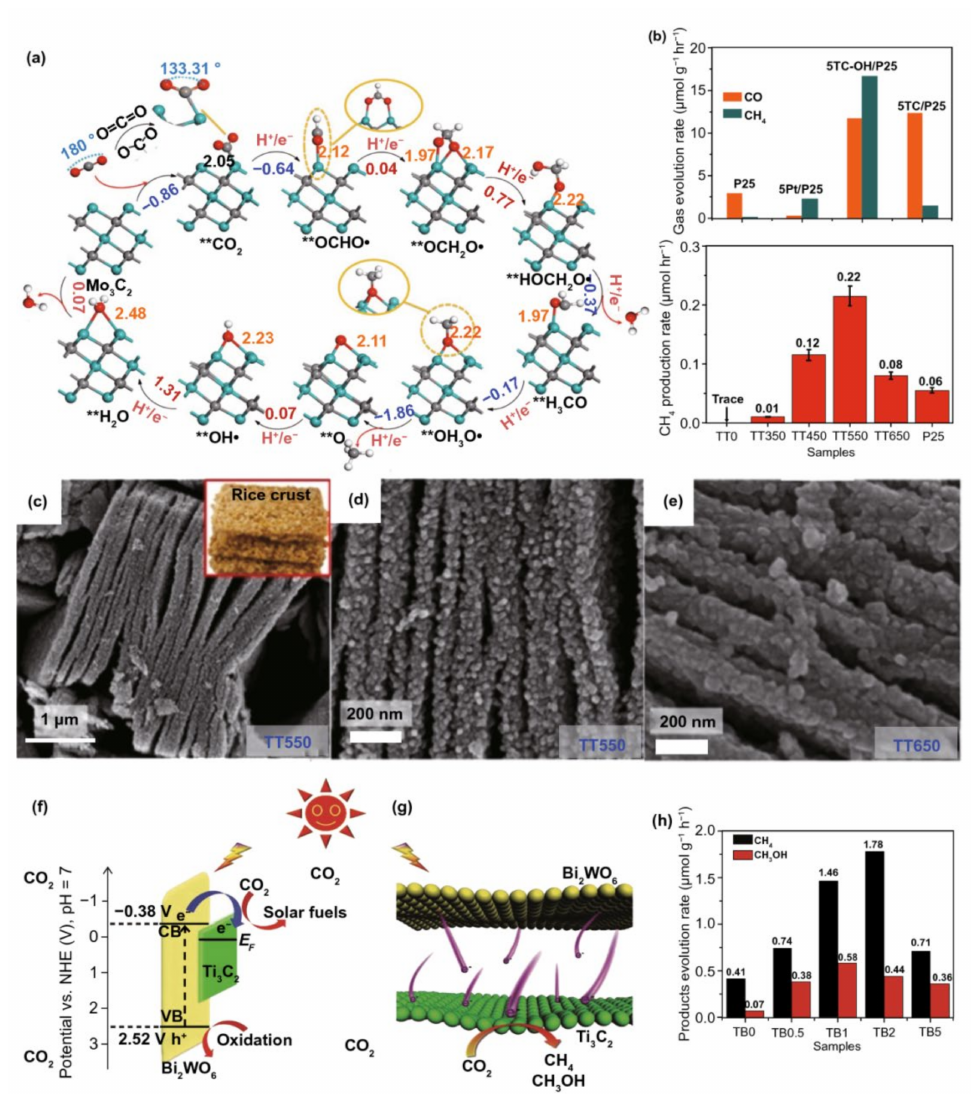
Figure 8. ( a ) For CO 2 to *CH 4 and **H 2 O conversion, the lowest amount of energy paths were explored, catalyzed by Mo 3 C 2 . Adapted from [123] Copyright 2017, American Chemical Society. ( b ) CO and CH